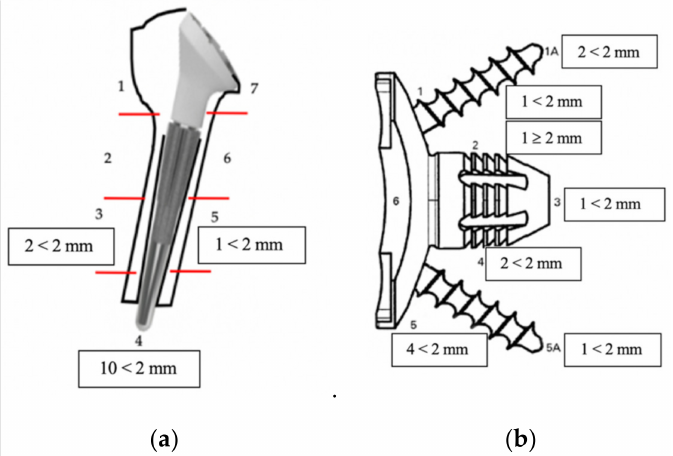
Figure 4. Image representing the frequency (number of cases) of RLL per zone of the humerus ( a ) and the glenoid ( b